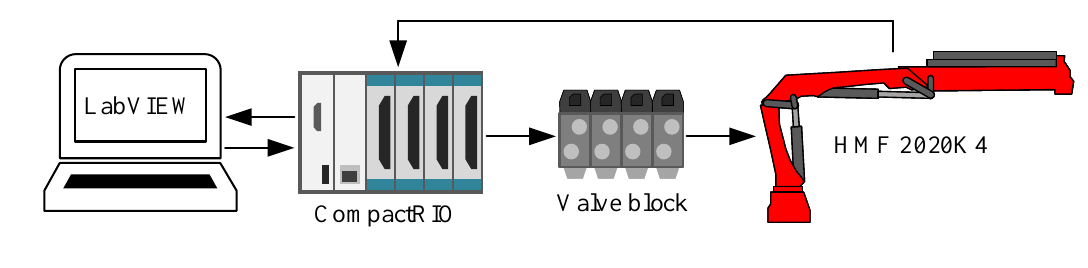
Figure 9. Connection between the crane and CompactRIO